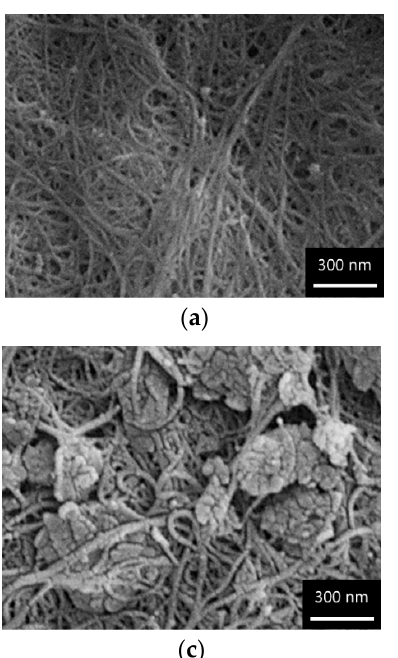
Figure 1. Pictures of ( a ) SWCNT BP, ( b ) 25% GO-SWCNT BP, ( c ) 50% GO-SWCNT BP, ( d ) 75% GO- SWCNT BP, and ( e ) 85% GO-SWCNT BP. All samples, except for 85% GO-SWCNT BP (which showed evident macroscopic cracks), were easy detachable from the porous PTFE filter and resulted in ( f ) self-sustainable and flexible disks.